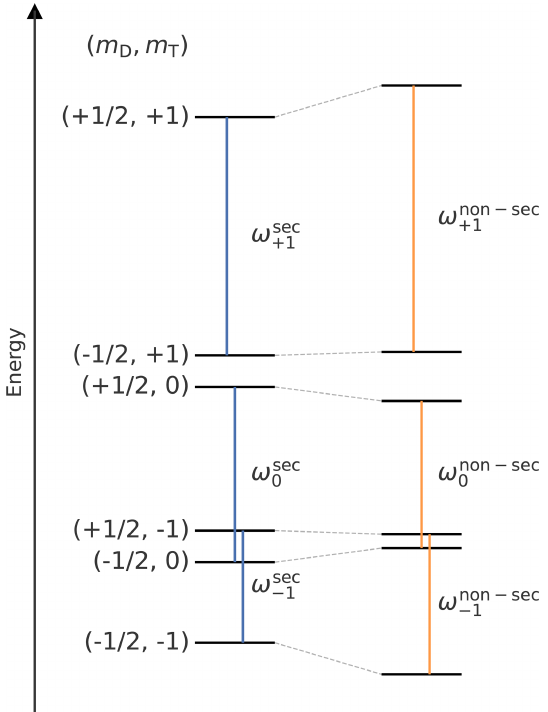
Figure 2. Energy level diagram (not to scale) after the transient triplet label has been excited to the triplet state demonstrating the shift that is induced by the non-secular terms of the ZFS and dipo- lar coupling from Eq. (S3). The energy levels in secular approxi- mation are shown on the left, and the levels with the non-secular terms are shown on the right. The vertical lines in blue (secular ap- proximation) and orange (non-secular terms included) indicate the coherences of the permanent spin label that are excited during the LaserIMD pulse sequence. They are marked with the corresponding transition